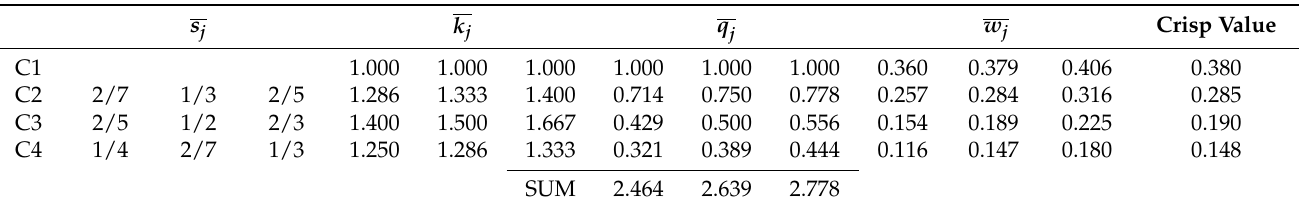
Table 4. Calculation process and weights of the main criteria applying improved fuzzy SWARA (IMF SWARA) in the same example.